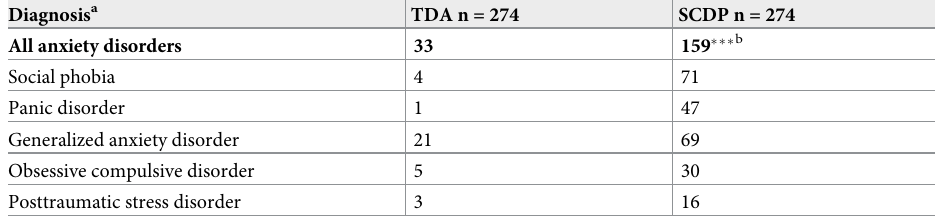
Table 5. Number of patients with different anxiety disorders for traditional diagnostic assessment (TDA) accord- ing to medical records and structured and comprehensive diagnostic procedure (SCDP) according to the study